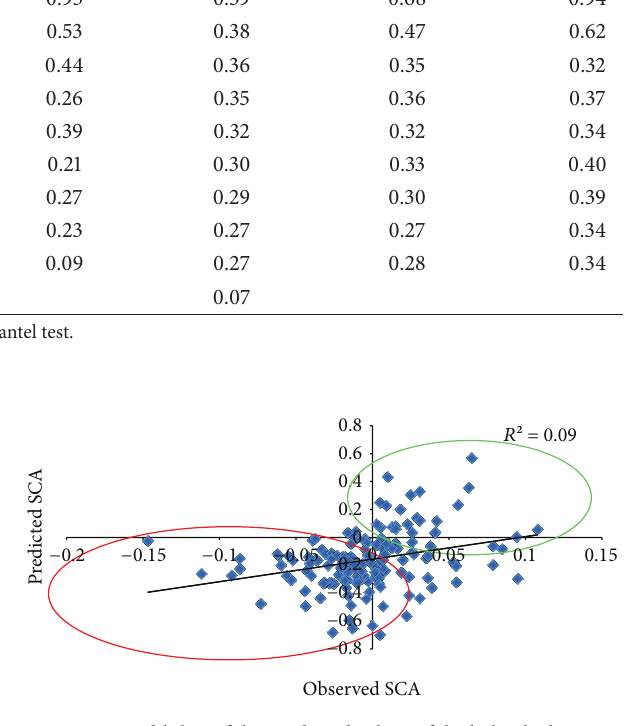
Figure 3: Credibility of the predicted values of the hybrids that were not tested by the TEAM2 method in the test population and the values recorded in the regional